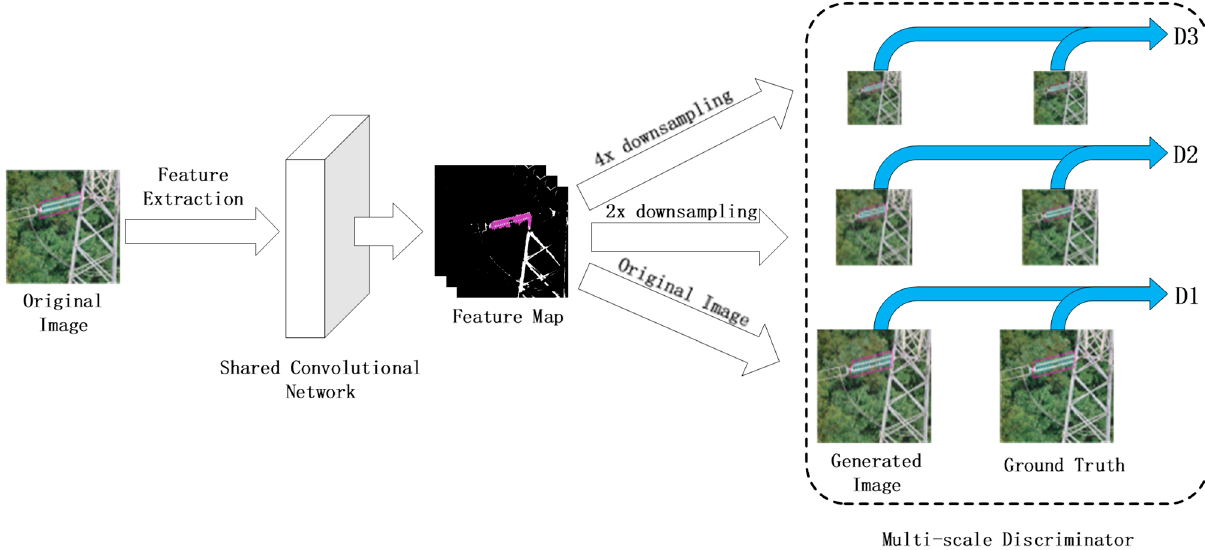
Figure 4. The framework of discriminators. The discriminator consists of three parts with the same structure: D 1 , D 2 , and D 3 . First, the shared convolutional layer is used to process the input image to obtain the feature map; after that, the map is down-sampled 2 times and 4 times and input into D 1 , D 2 , and D 3 to obtain the discriminator scores.